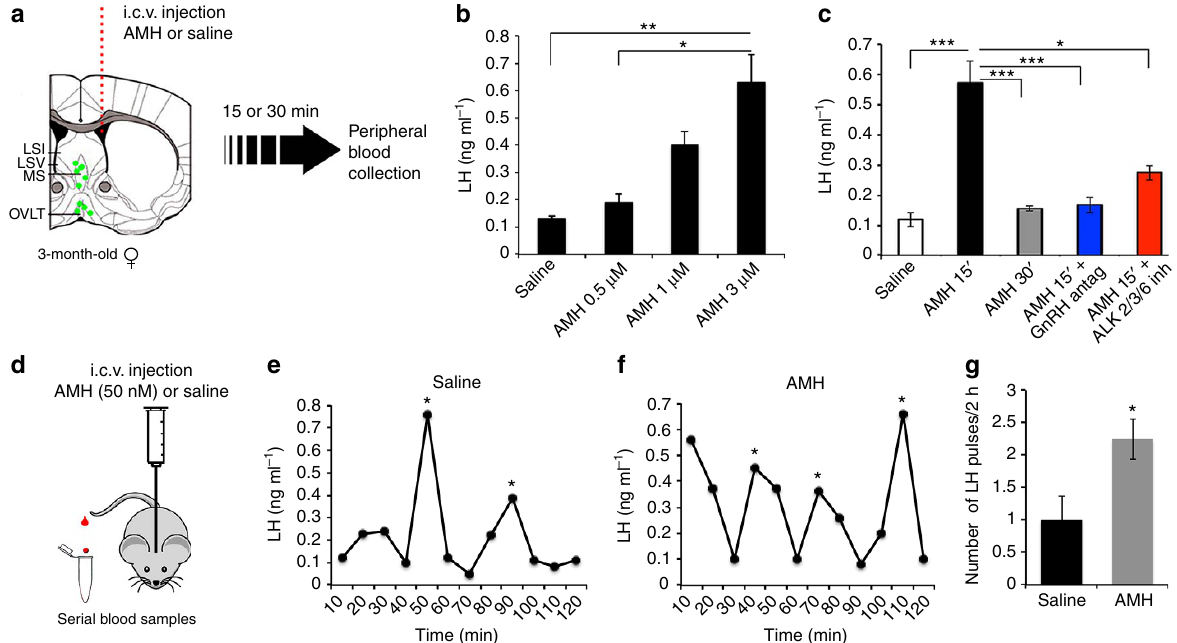
Figure 5 | Intracerebroventricular (i.c.v.) administration of AMH in vivo increases the LH secretion. ( a ) Schematic depicting AMH injection into the lateral cerebral ventricle of diestrous mice. Trunk blood was collected from 3–4-month-old mice 15 or 30min after the injection. ( b ) Following AMH administration (AMH 0.5 m M, n ¼ 3; AMH 1 m M, n ¼ 4; AMH 3 m M, n ¼ 6; saline, n ¼ 5), LH was measured. Values are expressed as means ± s.e.m. One-way analysis of variance, F (3,19) ¼ 6.6, P ¼ 0.004. * P : o 0.01, ** P : o 0.001, Fisher’s least significant difference post hoc test. ( c ) Adult diestrous mice were injected with AMH 3 m M ( n ¼ 20), or saline ( n ¼ 7). Plasma LH secretion peaked at 15min after injection and returned to basal levels 30min later ( n ¼ 7). AMH was injected i.c.v 2h after an intraperitoneal injection of the GnRH antagonist ( n ¼ 7). Treatment with an ALK receptor inhibitor prevented the AMH-dependent increase in LH secretion ( n ¼ 6). One-way analysis of variance, F (4,47) ¼ 11.1, P o 0.0001. * P o 0.01, *** P o 0.0001, Fisher’s least significant difference post hoc test. ( d ) Schematic representation of AMH injection into the lateral cerebral ventricle of diestrous (3–4-month old) mice with 50nM AMH or saline. Tail blood was collected every 10min for 2h and LH measured ( n ¼ 7 control, n ¼ 8 AMH; e – g ). Asterisks in e and f indicate LH pulses in two -representative saline- and AMH-treated mice. Values are represented as means ± s.e.m. Unpaired Student’s t -test, t (13) ¼ (cid:2) 2.56, * P o 0.05. Experiments were replicated three times. MS, medial septum; LSI, lateral septal nucleus, intermediate part; LSV, lateral septal nucleus, ventral part; OVLT, organum vasculosum of the lamina 0.36 ng ml (cid:2) 1 ± 0.06; Student’s t -test: P ¼ 0.8) and, in addition